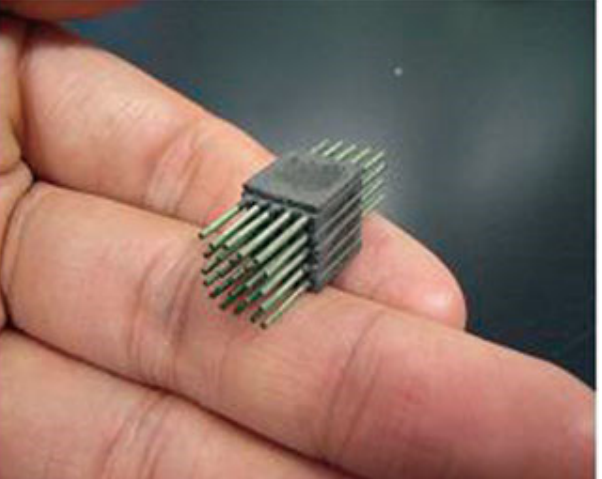
Figure 9. Schematic of a micro-tubular SOFC (figure reprinted from Hanna et al. [55] Copyright (2014), with permission from Elsevier).